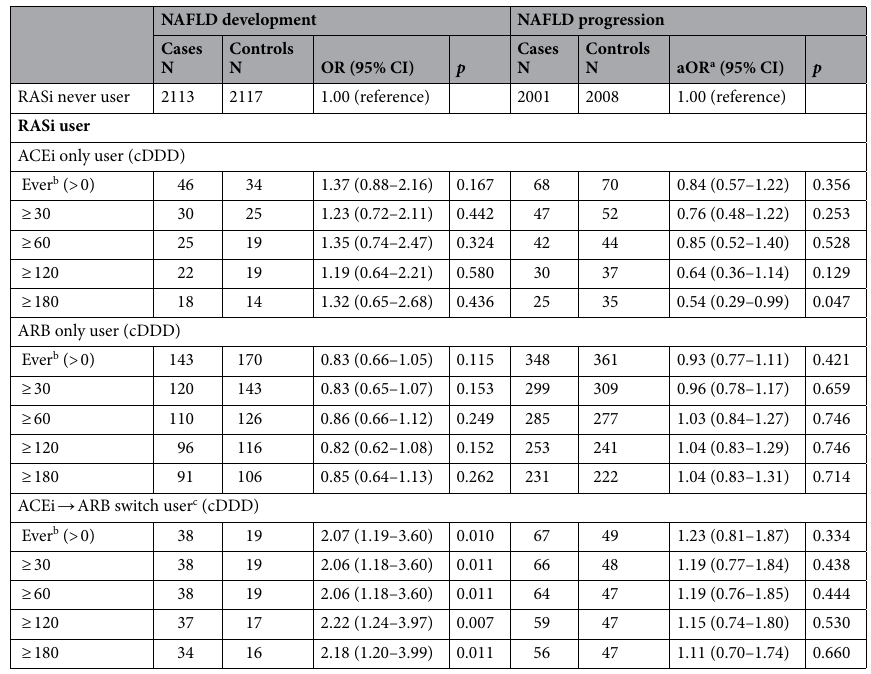
Table 4. Risk of NAFLD development and progression according to the types of RASi. a Adjusted for age, body mass index, waist circumference, fasting plasma glucose, α-glucosidase inhibitors, β-blocker, metformin, sulfonylurea, thiazolidinedione, Charlson Comorbidity Index score, diabetes, hypertension. b Multivariable conditional logistic regression including RASi never user, ACEi only user, ARB only user, and ACEi → ARB switch user groups. c Individuals who used ACEi before the first prescription of ARB. ACEi angiotensin converting enzyme inhibitor, ARB angiotensin receptor blocker, cDDD cumulative daily defined dose, CI confidence interval, OR odds ratio, RASi renin–angiotensin–aldosterone system inhibitors, NAFLD non- alcoholic fatty liver